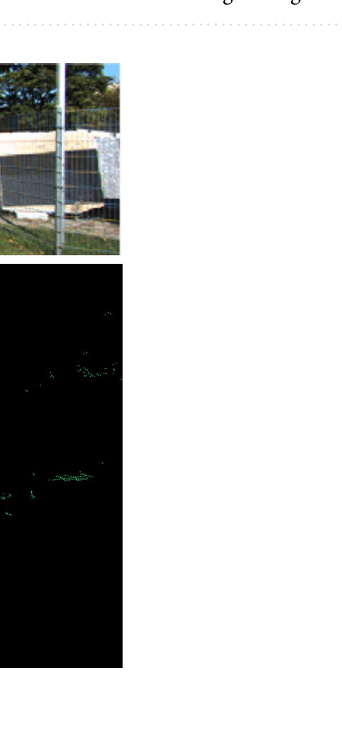
Figure 3. Dense LiDAR image generation: ( a ) RGB image, ( b ) projective image (RGB image with a superimposed sparse point cloud), ( c ) generated sparse LiDAR depth image, ( d ) generated sparse LiDAR height image, ( e ) generated dense LiDAR depth image, and ( f ) generated dense LiDAR height image.